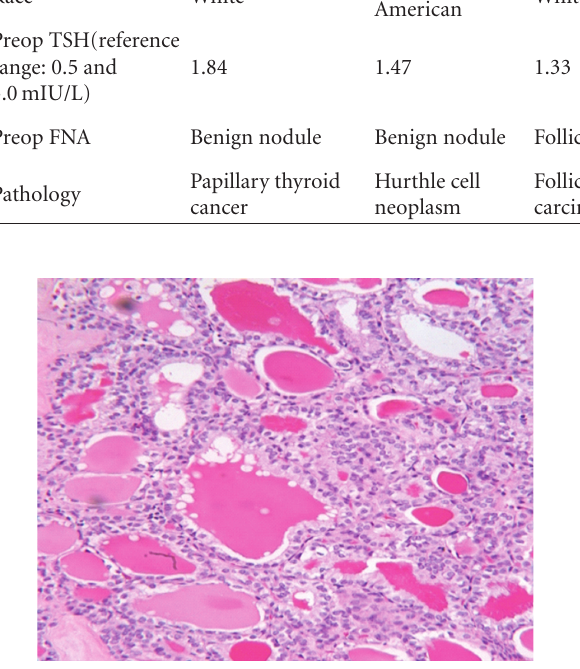
Figure 1: Follicular variant of papillary thyroid carcinoma.